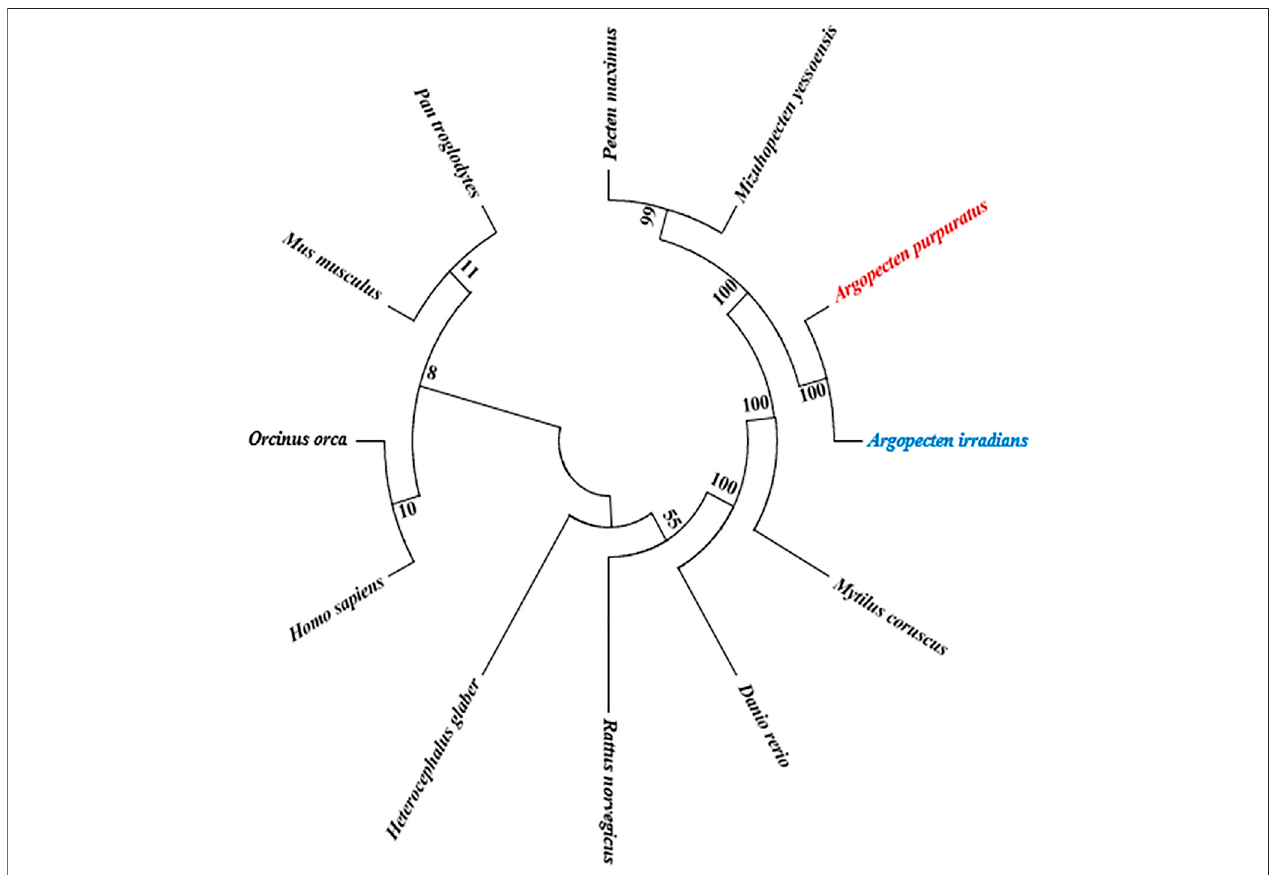
FIGURE 5 | NJ phylogenetic analysis of ApPTEN and AiPTEN with other